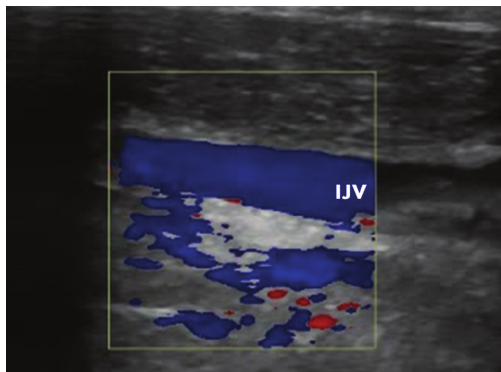
Figure 5: Normal flow in the left internal jugular vein three weeks following surgical